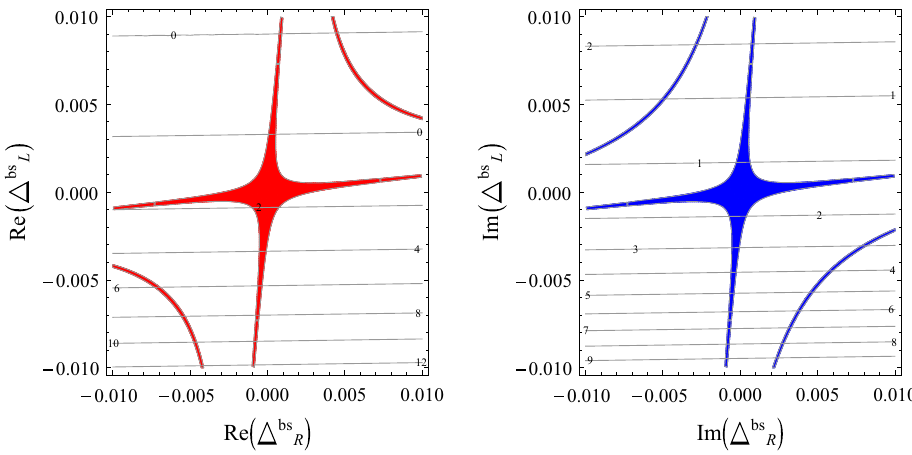
ηρ 0 in the LRS for the case Im ((cid:5) sb 2